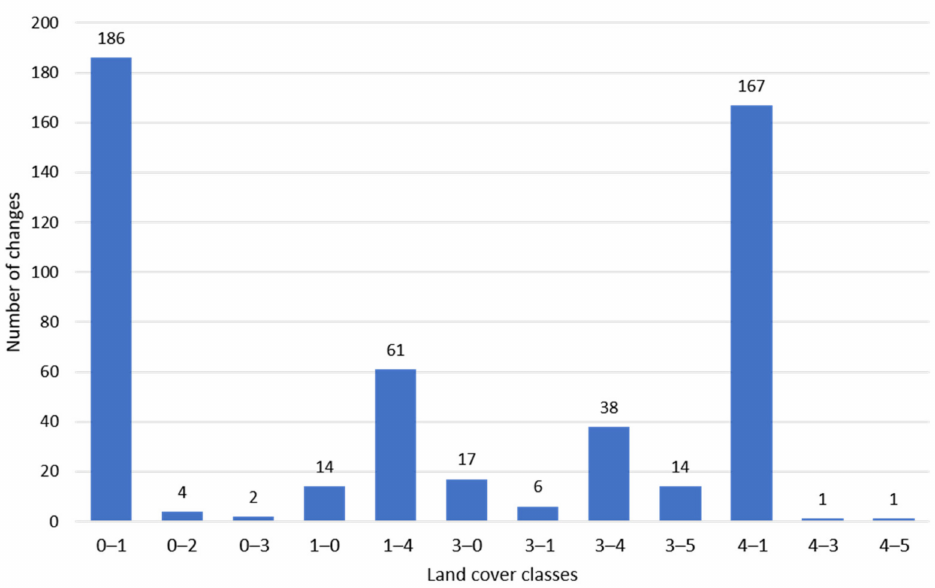
Figure 14. Changes of land cover classes in 2018–2019.